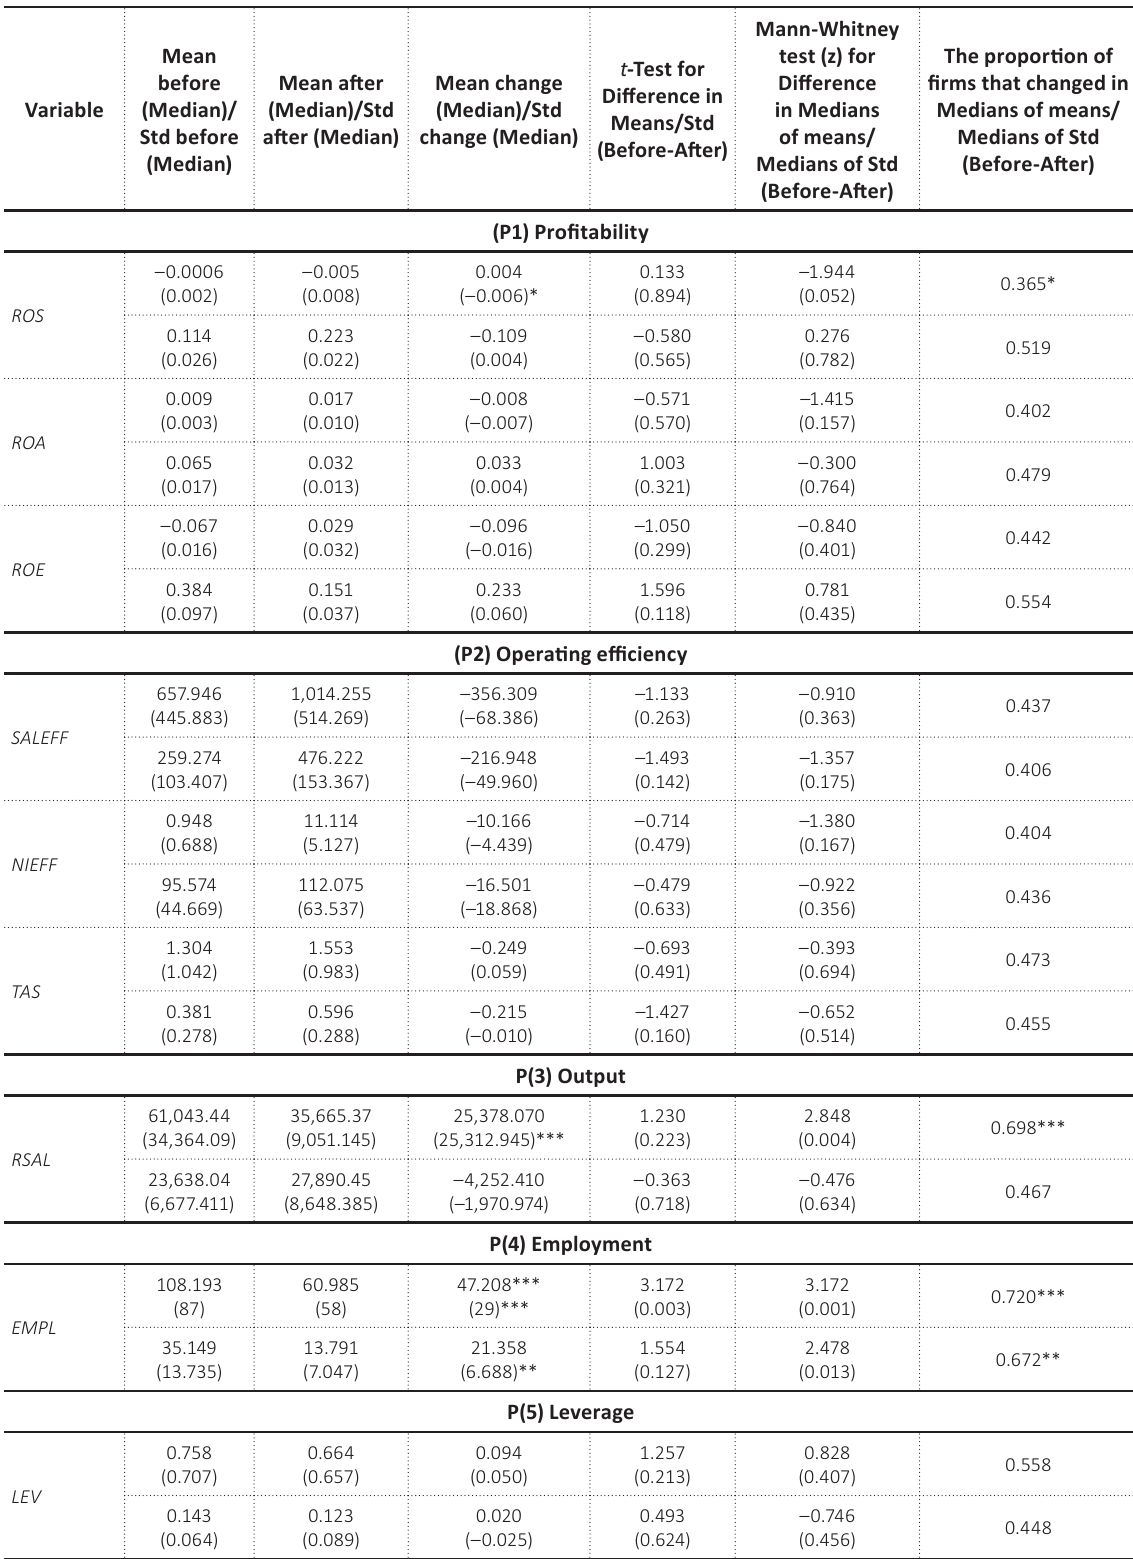
Table A6. Performance changes of small and medium-sized SOEs after privatization (privatized SOEs with tax